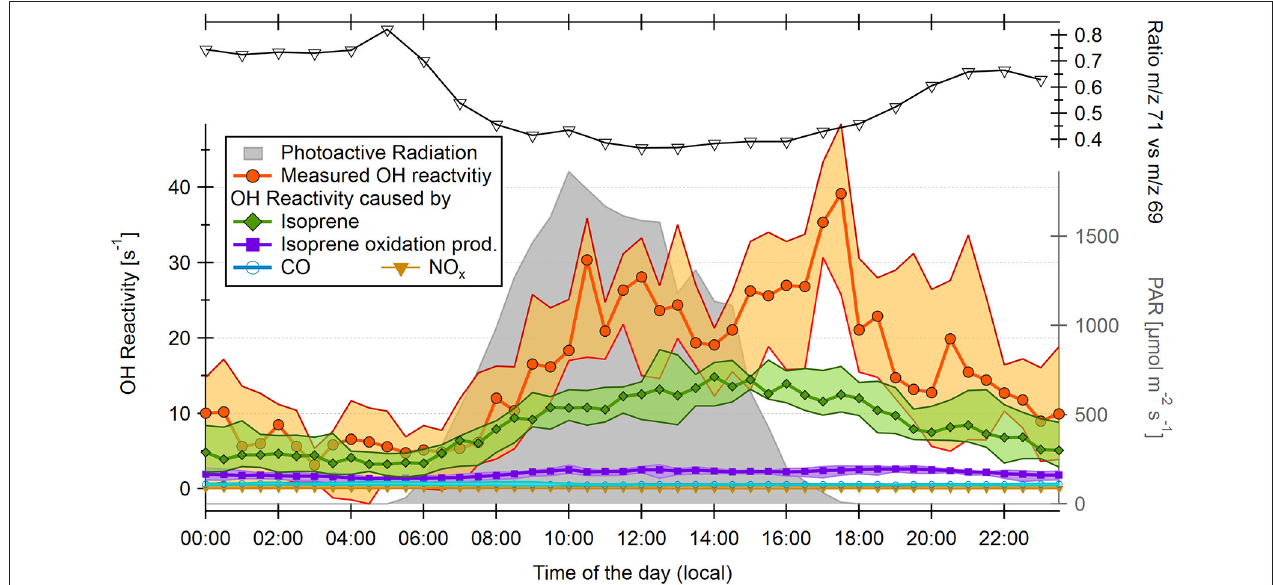
FIGURE 4 | Diel half-hourly medians over 13 days of measurements in November 2015 for calculated OH reactivity of isoprene, isoprene oxidation products, NO x and CO, diel medians of measured OH reactivity; and hourly medians of the isoprene oxidation product vs. isoprene ratio. Filled areas represent the 25–75th percentiles of data. Not depicted: contributions of ozone (max. 0.05 s − 1 ), and methane (max. 0.22 s − 1 ). Photosynthetic active radiation (PAR) is displayed on the right axis (half-hourly